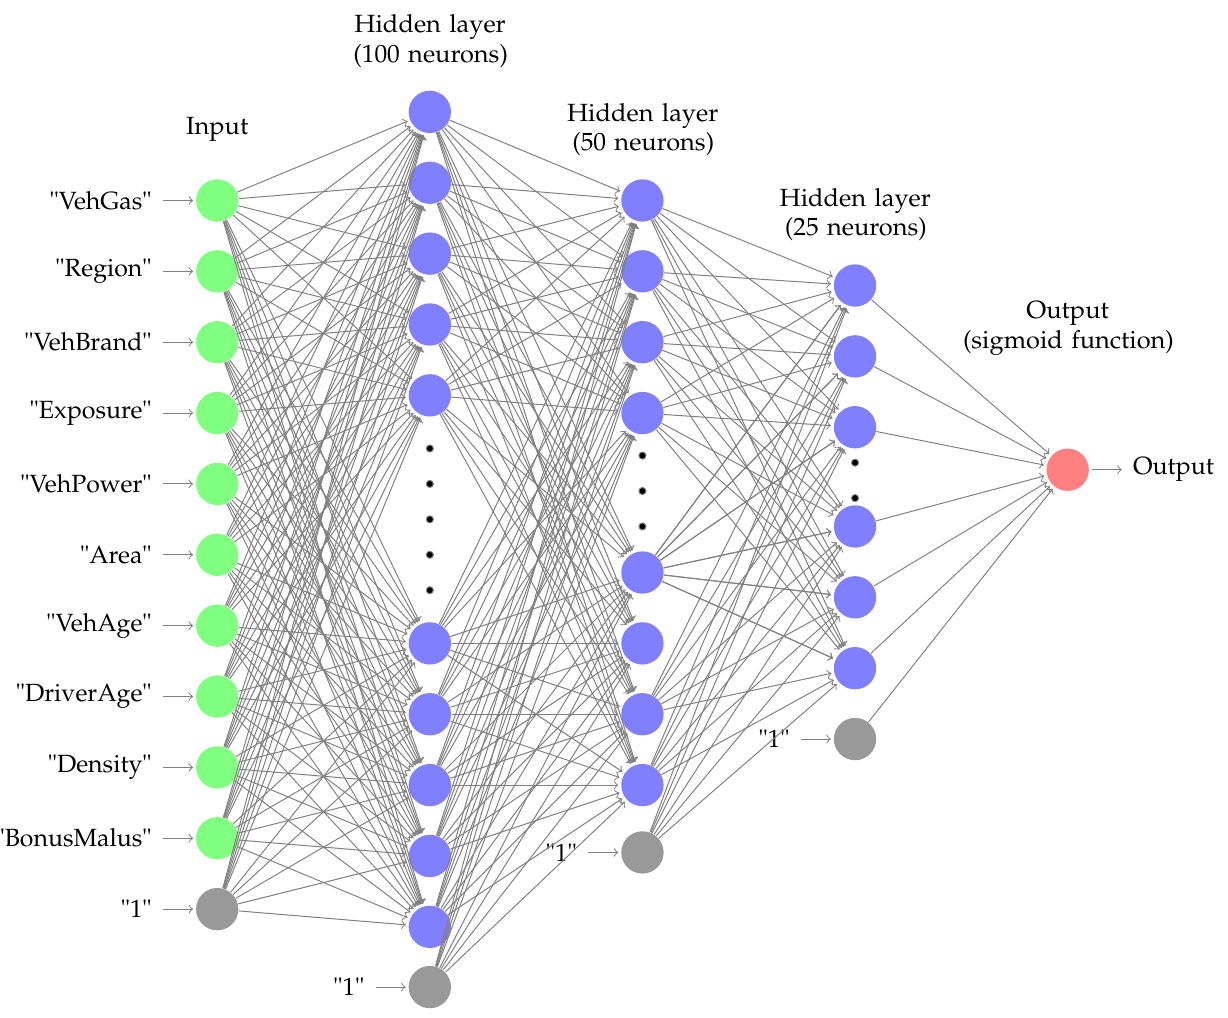
Figure 1. A multilayer perceptron neural network with three hidden layers. The last neuron in each layer is the intercept